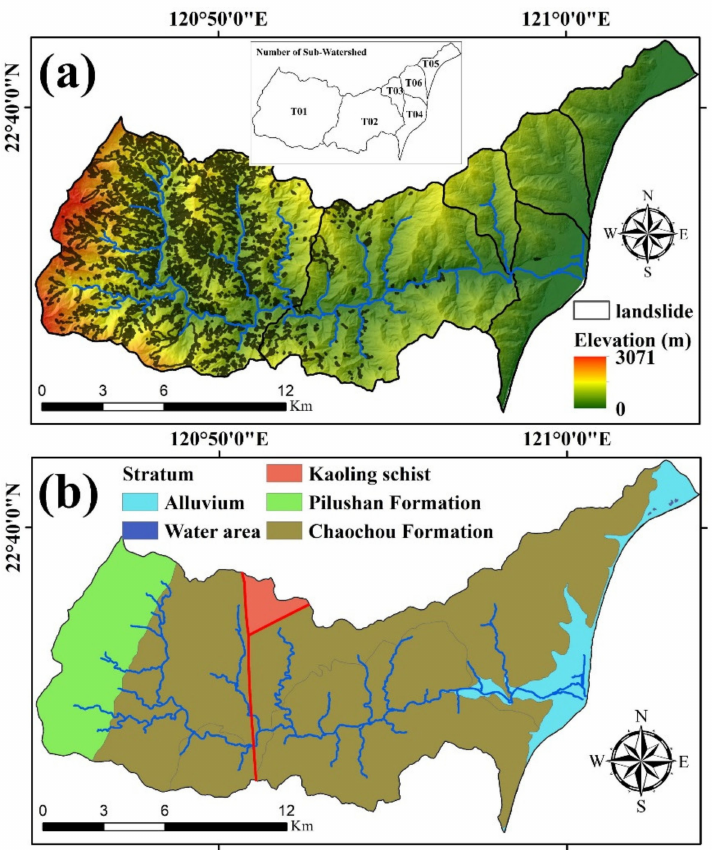
Figure 4. The distribution of elevation, landslide after 2009 Typhoon Morakot, and sub-watersheds ( a ), geological settings ( b ) in the